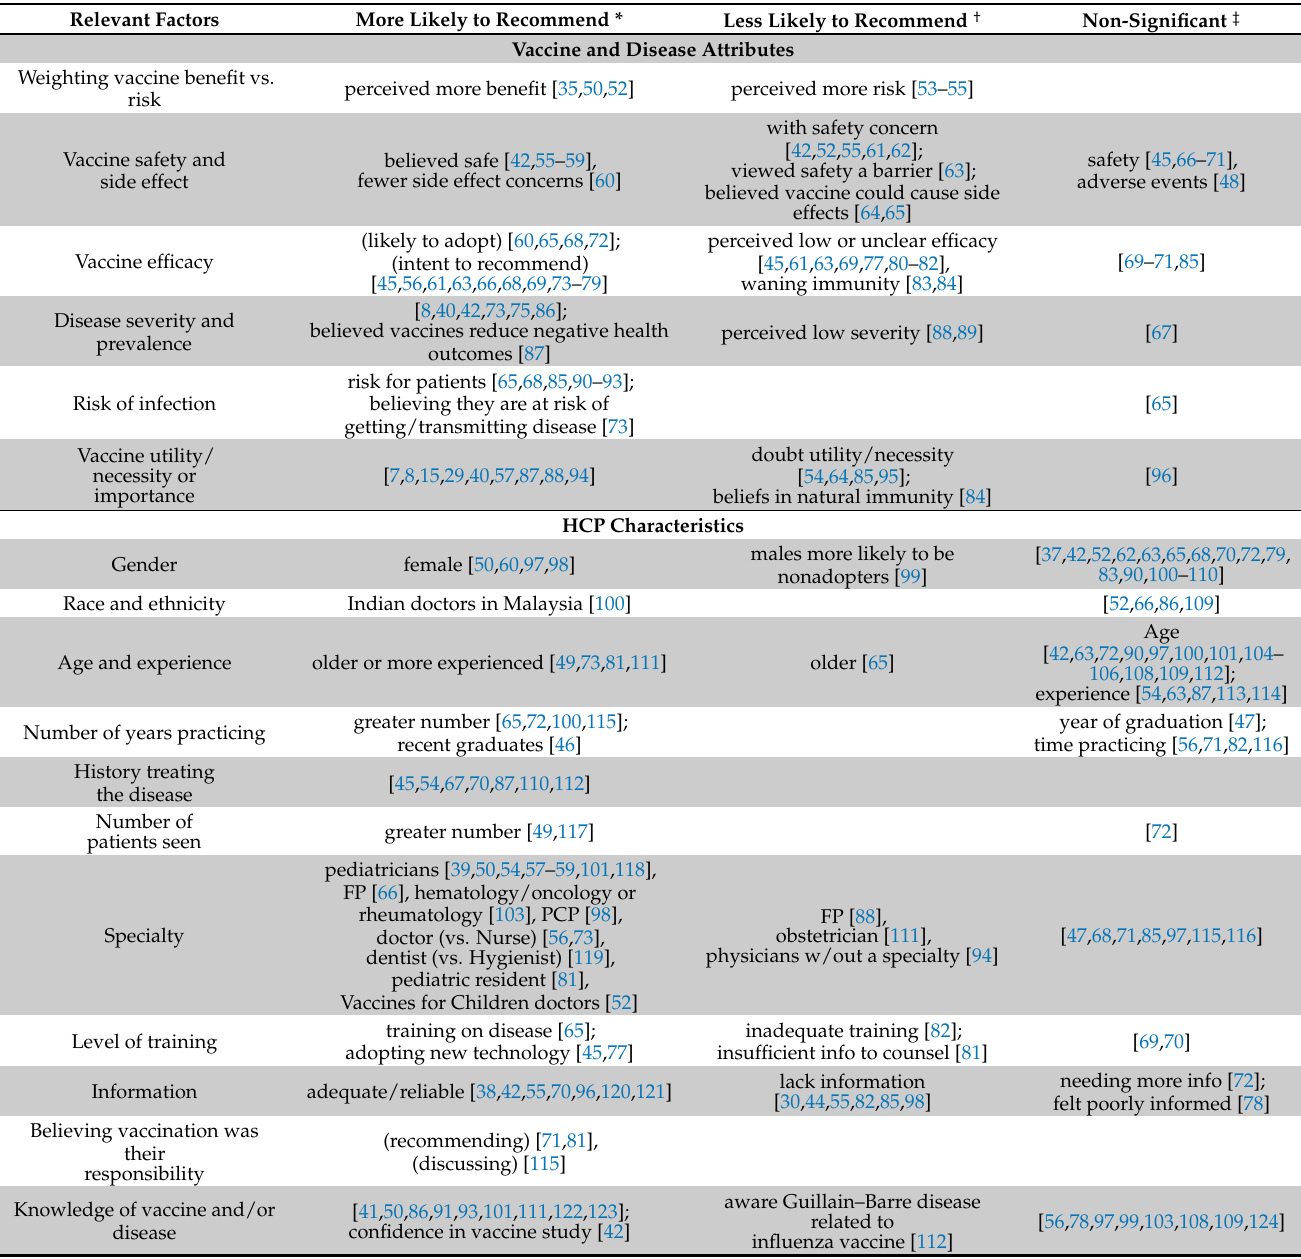
Table 1. Factors associated with HCP recommending or providing vaccination to